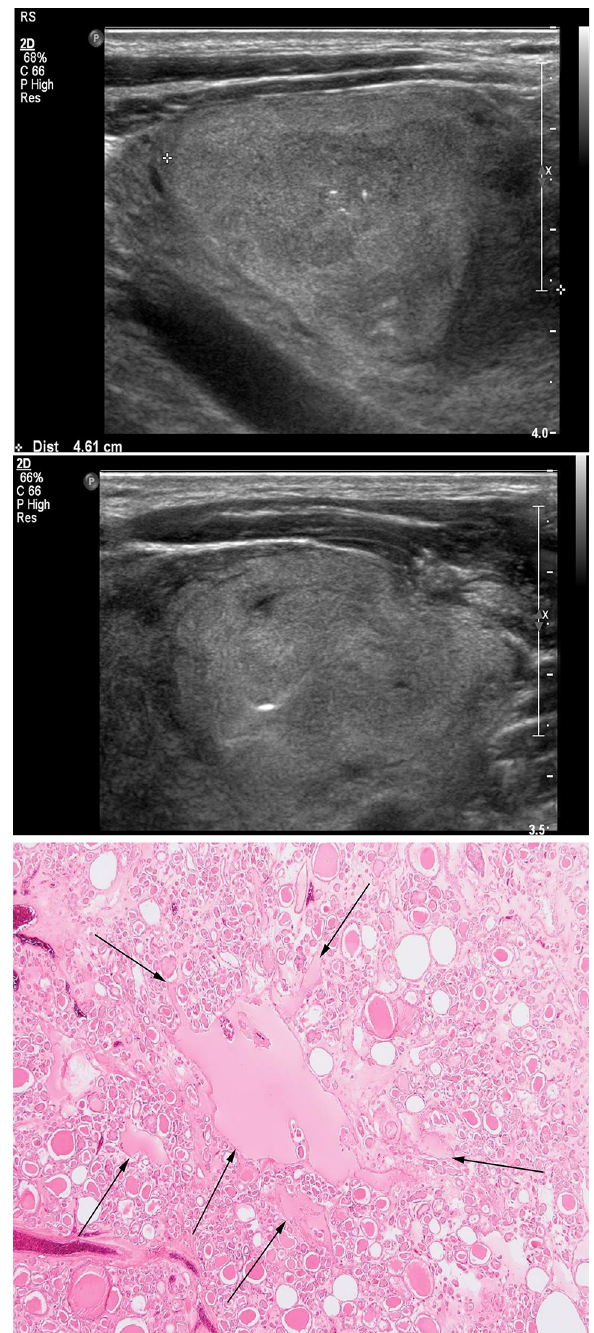
Fig 2. Images of a representative case of follicular adenoma. A 59-year-old man was diagnosed with follicular adenoma on US. (a) An US image showing a 4.6 cm–sized oval predominantly solid isoechoic nodule with internal microcalcification. (b) US-guided FNA is performed with a 21-gauge syringe, and the nodule is suspicious for a follicular neoplasm. (c) The surgical specimen shows microfollicular proliferation with one macrofollicle containing three pieces of intrafollicular calcification corresponding to the ultrasonographic image shown in Fig 2A (arrows). × 40 original magnification. Hematoxylin and eosin staining is used. US, ultrasonography; FNA, fine-needle aspiration.